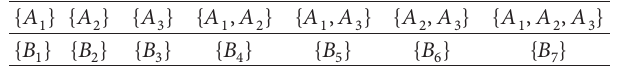
Table 3: The subset of three alternatives and their short